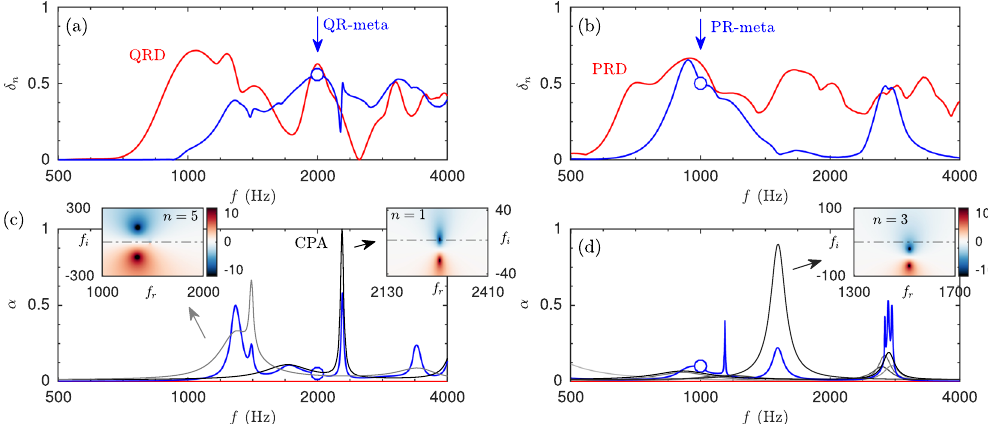
Figure 5. ( a ) Diffusion coefficient of the QR-metadiffuser (blue) optimized at 2000 Hz (marker) and a reference QRD (red). ( b ) Diffusion coefficient of the PR-metadiffuser (blue) optimized at 2000 Hz (marker) and a reference PRD (red). ( c ) Corresponding absorption for the QRD case, where the grey lines shows the absorption of individual slits n = 1 and n = 5. For these slits, the insets show the complex frequency representation 26 of the reflection coefficient (log| R ( f r , f i )| 2 ), where f r = Re( f ) and f i = Im( f ). ( e ) Corresponding absorption for the PRD where the complex frequency representation of the reflection coefficient is shown for the individual slit n = 1 in the inset.